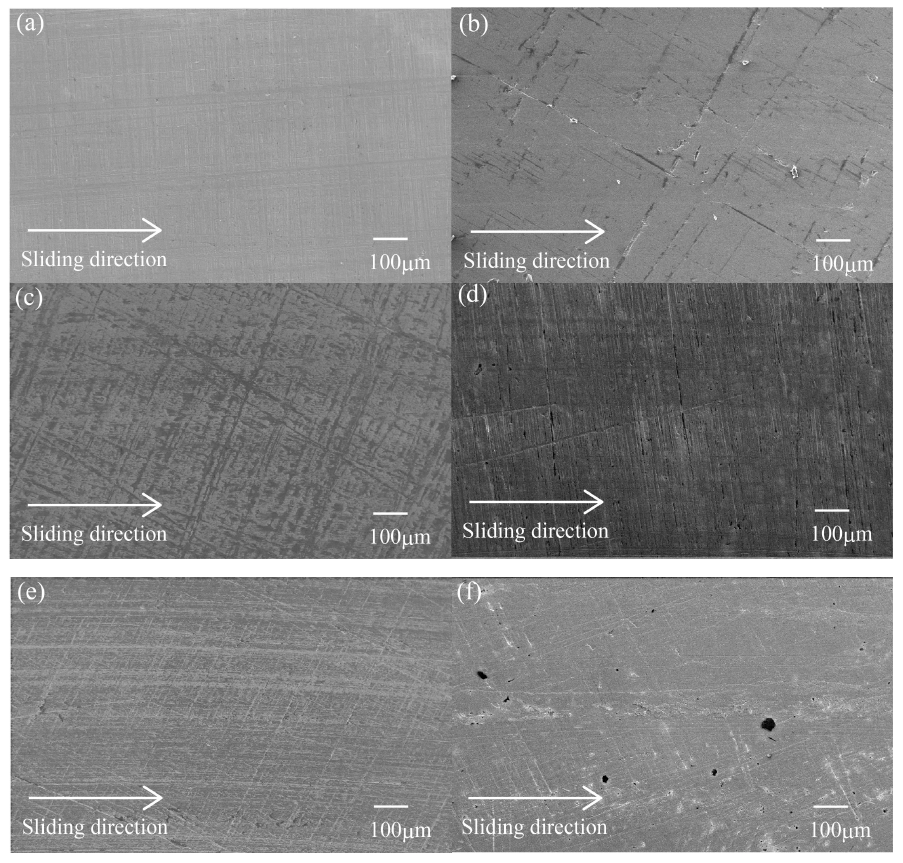
Figure 5. SEM photographs of the metallic counterface before and after sliding wear tests of various surface-treated HF/PA1010 biomass composites ( V f = 20 vol %): ( a ) Before test; ( b ) PA1010; ( c ) HF; ( d ) HF-S1; ( e ) HF-S2 and ( f ) HF-S3.